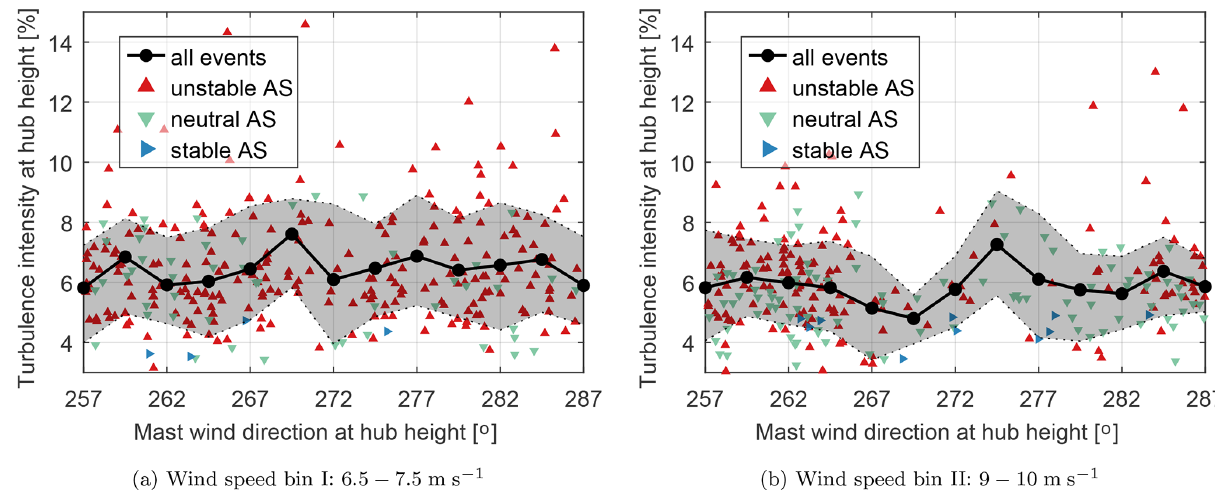
Figure 4. Turbulence intensity measured at 90m height at FINO1. Statistics are shown as mean values per wind bin. The shaded area indicates the 15th and 85th percentiles. Scatter shows TI of single 10min events. AS = atmospheric stability.